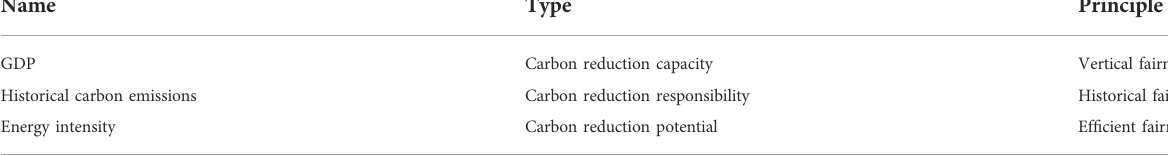
TABLE 1 The index system of carbon permit allocation based on the fairness